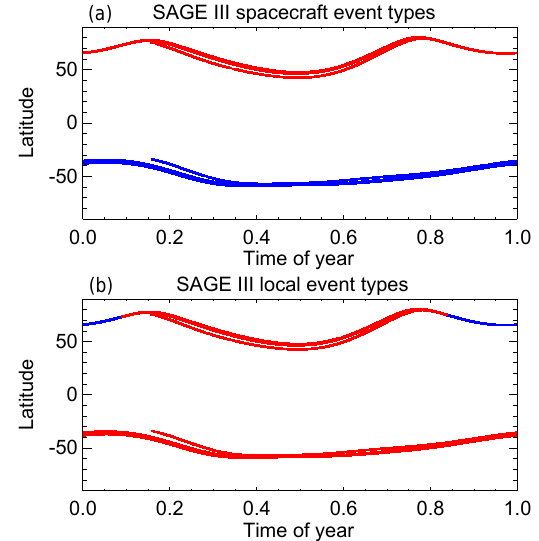
Figure 1. Location of all SAGE III occultation events for both spacecraft (a) and local (b) event types. In each case, sunrises are shown in blue while sunsets are shown in red. While there is a clear hemispheric distinction between spacecraft event types, nearly all local event types are sunsets with the exception of spacecraft sun- set events in polar winter. Other occultation instruments in sun- synchronous orbits such as POAM II and POAM III exhibit similar